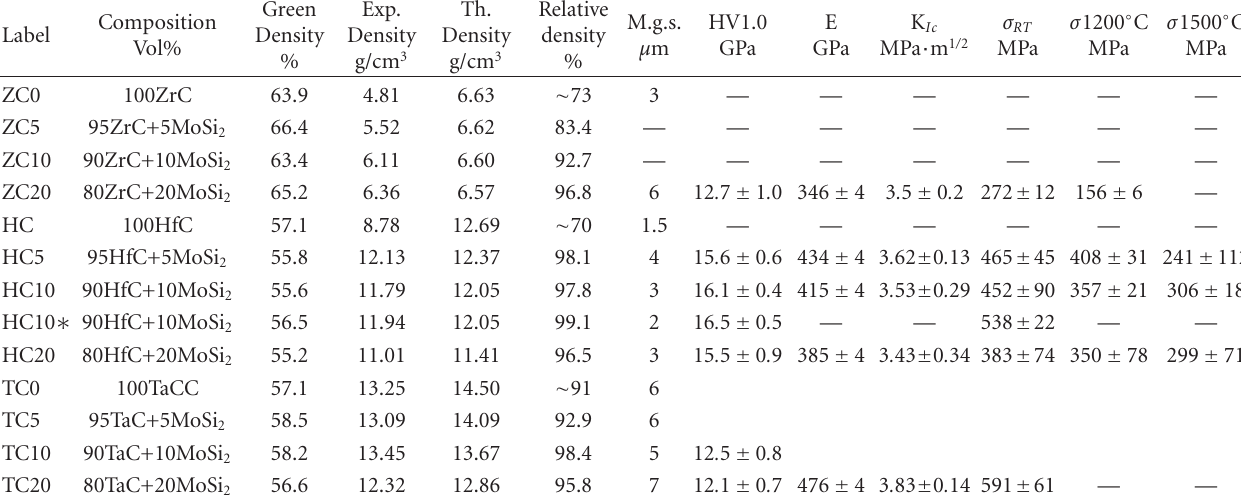
Table 2: Densification data for the samples pressureless sintered at 1950 ◦ C/60min in flowing Ar; Mean grain size of the matrix and mechanical properties of the composites: hardness (HV1.0), Young’s modulus (E), fracture toughness (K Ic ) by CNB method, and 4-pt flexural strength ( σ ) at room and high